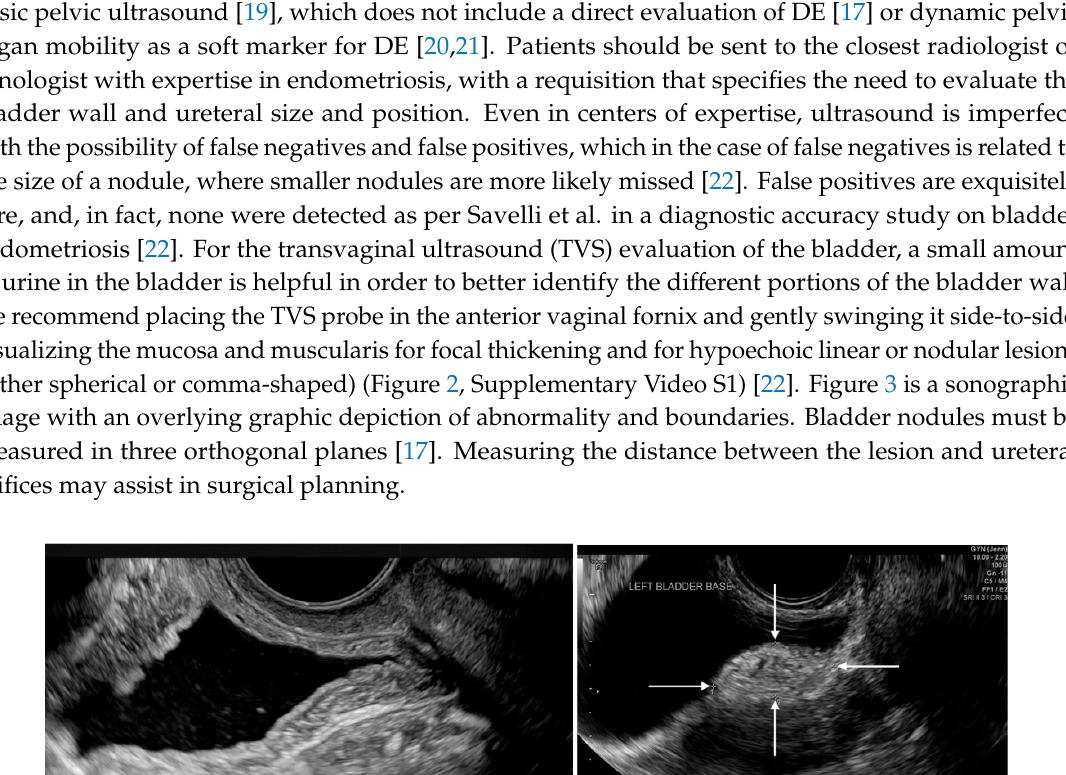
Figure 3. Bladder base deep endometriosis nodule encroaching on the bladder dome. The pelvic segment of the ureters can be examined next by moving the TVS probe from the midline toward the pelvic sidewalls. Operators should search for a long tubular hypoechoic structure with a thick hyperechoic outer wall extending from the lateral aspect of the bladder base towards the common iliac vessels [23]. Vermiculation and/or the absence of color Doppler within the tubular structure can be used to confirm that it is a ureter rather than a vessel. The goal is to then follow the ureter as proximally as possible, in the direction of its origin, assessing for dilatation, position, any